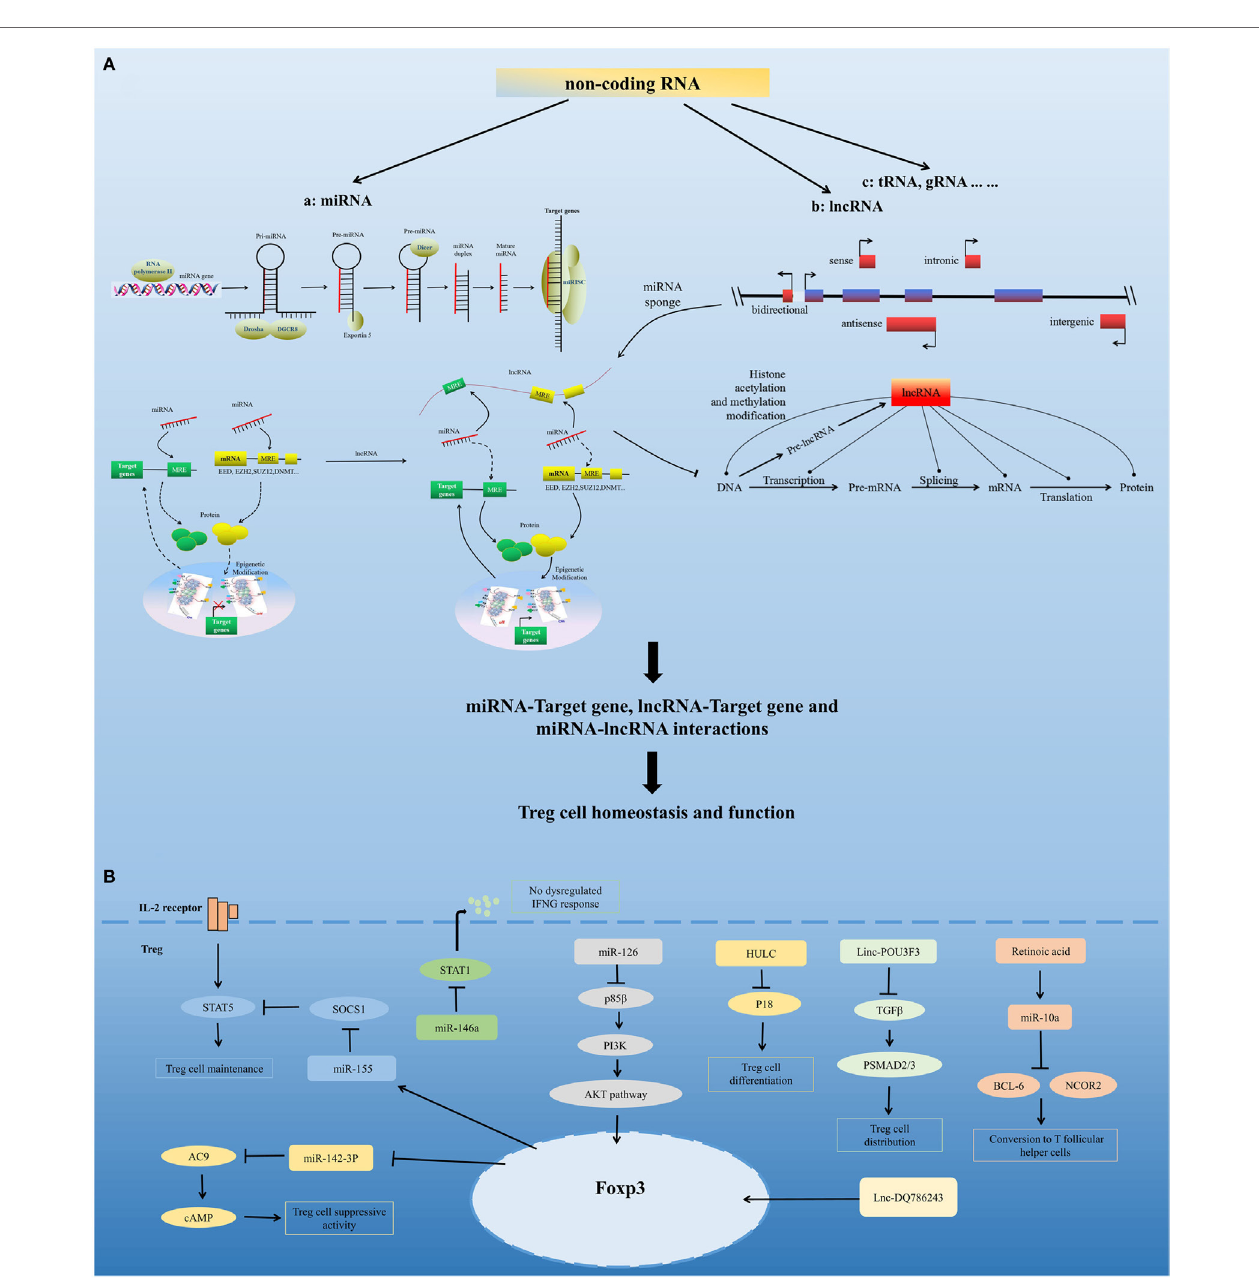
FiGURe 2 | Non-coding RNA-mediated regulation of Treg cell homeostasis and function . (A) Model for non-coding RNAs (ncRNA)-mediated regulation of Treg cell homeostasis and function. ncRNAs include highly abundant and functionally important RNAs, such as microRNAs (miRNA), long non-coding RNAs (lncRNA), and tRNA. miRNAs are sequentially processed from longer transcripts by the RNase III enzymes Drosha and Dicer. Pri-miRNAs are processed by Drosha into hairpin structures (pre-miRNAs). Exportin 5 shuttles pre-miRNAs from the nucleus into the cytoplasm, where the RNase III Dicer cleaves off the hairpin loop of the pre-miRNA. The duplex segregates, and the mature single-stranded miRNA associates with argonaute proteins and other accessory proteins to form the miRNA-induced silencing complex, which directly mediates the translational repression and the increased degradation of its mRNA targets. miRNA can also indirectly regulate gene expression by repressing the expression of several key enzymes involved in epigenetic modification processes, such as DNA methylation and histone modification. Based on the position of lncRNA relative to the neighboring protein-coding genes in the genome, lncRNAs can be divided into five categories, namely, sense, antisense, bidirectional, intronic, and intergenic. lncRNAs can modulate chromatin modification, mRNA stability, miRNA activity, and the function of proteins by interacting with chromatin, RNA, and protein. lncRNA functions as a miRNA sponge, sequestering miRNAs to regulate the expression level of other transcripts sharing common miRNA response elements. This process leads to fewer miRNA molecules available to bind to target mRNA and, thus, an increase in its protein expression level. miRNA, lncRNA, and mRNA form a well-regulated interacting network and play critical regulatory roles in Treg cell homeostasis and function. (B) Regulation of Treg cells by several representative miRNAs and lncRNAs, including miR-155, miR-146a, miR-126, miR-10a, miR-142-3p, HULC, Linc-POU3F3, and